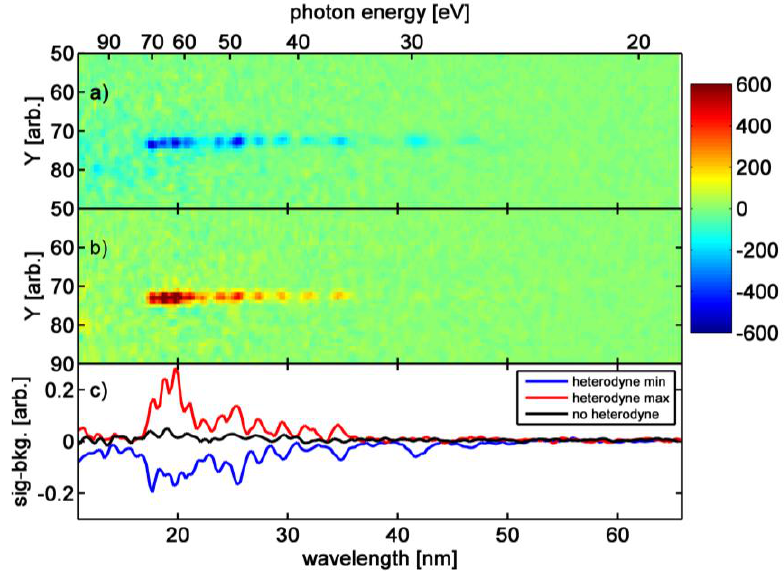
Figure 3. ( a ) Difference image of signal without transient grating minus transient grating diffraction. The blue color at the position of the harmonic trace from Figure 2 clearly indicates a negative difference signal due to heterodyning. The red harmonics in ( b ) show a constructive interference due to the heterodyne term. Integrated signals are shown in ( c ) together with a measurement that shows no heterodyne contribution due to absence of the permanent grating on a fresh sample